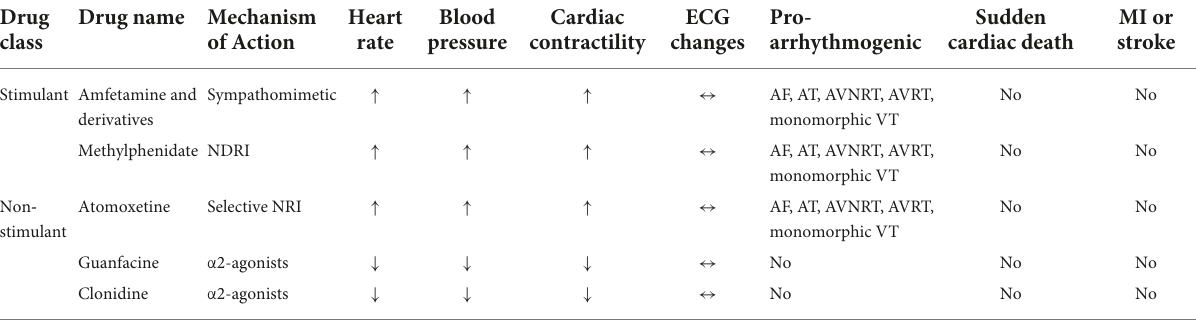
TABLE 1 The cardiovascular effects of medications used to treat ADHD in the general population. Drug